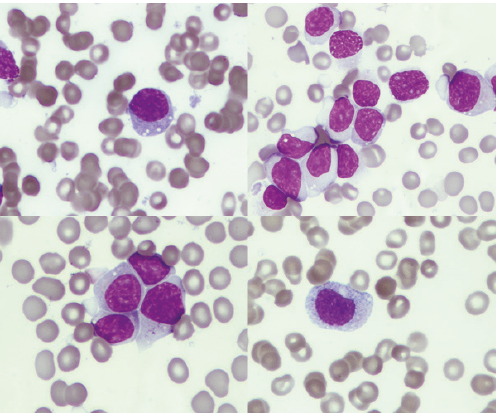
Figure 2: Bone marrow cytomorphology findings. Composite image of circulating leukemic cells obtained from Wright-Giemsa- stained peripheral blood